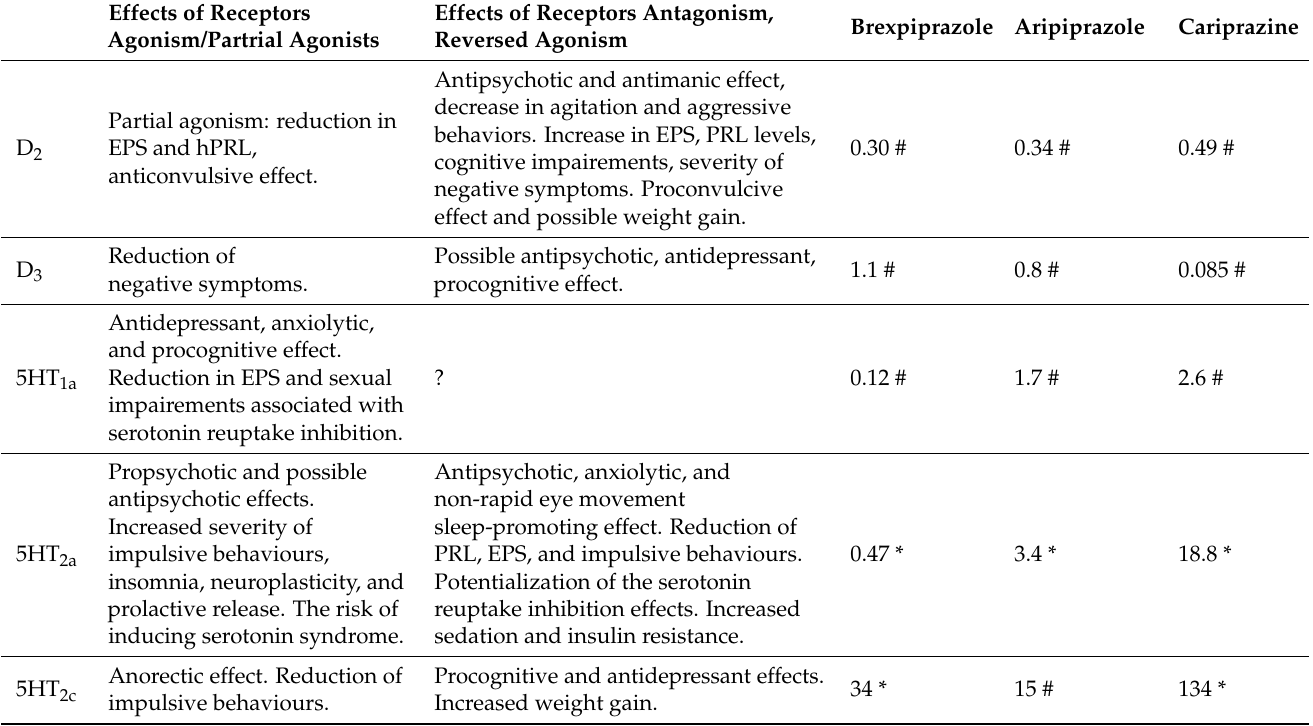
Table 1. The comparison of affinities of brexpiprazole and other partial agonists of D 2 for specific receptors. Additionally, clinical effects of agonism and antagonism of those receptors has been summarized based on